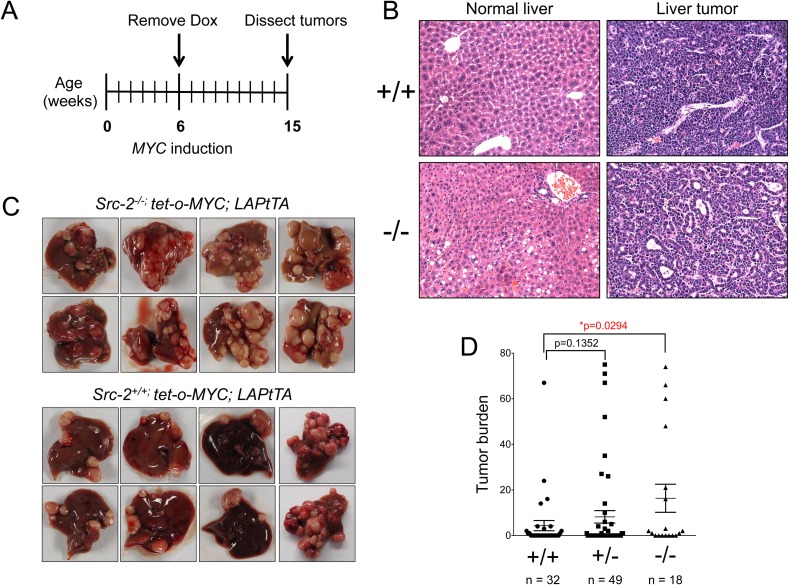
Acceleration of liver tumorigenesis in Src-2-/-; tet-o-MYC; LAPtTA mice.(A) Timeline of MYC induction. Dox, doxycycline. (B) Hematoxylin and eosin (H&E) staining of normal liver and liver tumors from Src-2-/- and Src-2+/+ mice. (C) Representative images of multifocal liver tumors from Src-2-/- and Src-2+/+ animals overexpressing MYC in liver. (D) Quantification of tumor burden from animals that formed liver tumors at time of dissection (15 wk). n = 32 for animals with wildtype (+/+) Src-2, n = 49 for Src-2 heterozygotes (+/-) and n = 18 for Src-2 knockout mice (-/-); Src-2 (+/+) vs. (-/-) mice,*p = 0.0294, Wilcoxon rank sum test.